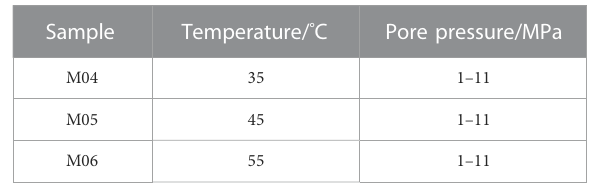
TABLE 3 Adsorption experiment program.